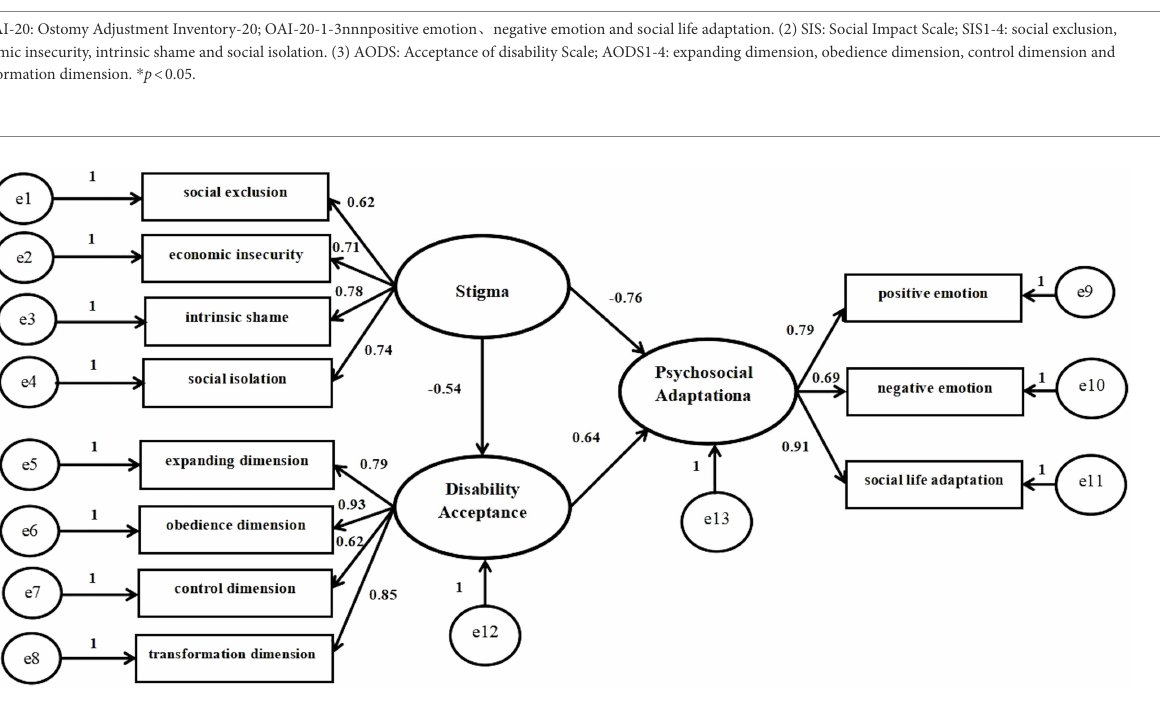
Furthermore, Stigma has a significant indirect effect on psychosocial adaptation via disability acceptance ( β = 0.053, p< 0.01, 95% confidence interval (95%CI) [0.028, 0.125]. Table 6 represents the specific effect values of each path in this model. Therefore, the hypothesis model of this study fitted the data well, and the results showed that disability acceptance positively affected psychosocial adaptation, while stigma negatively affected psychosocial adaptation. It was also found that disability acceptance mediated between stigma and psychosocial adaptation.